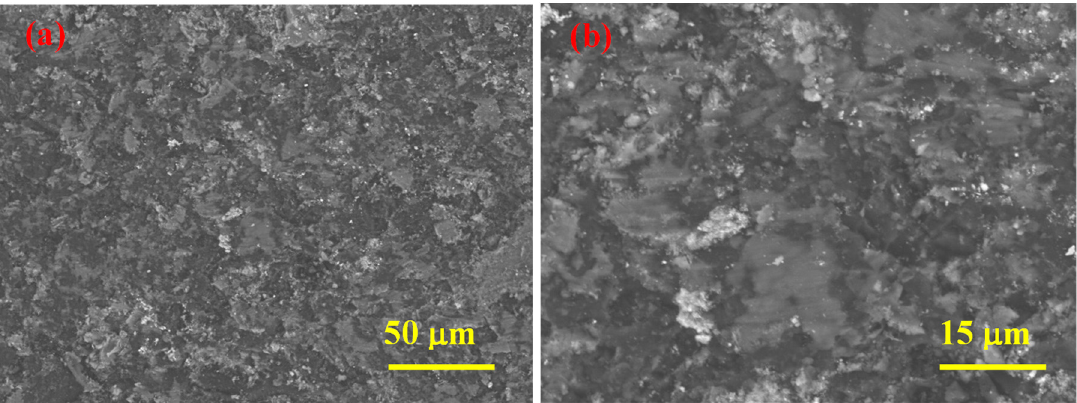
Figure 9. SEM micrographs at two magnifications of sample 5 (SPS-consolidated B 4 C) taken after the erosion test at impact angle of 30 ° (a, b).